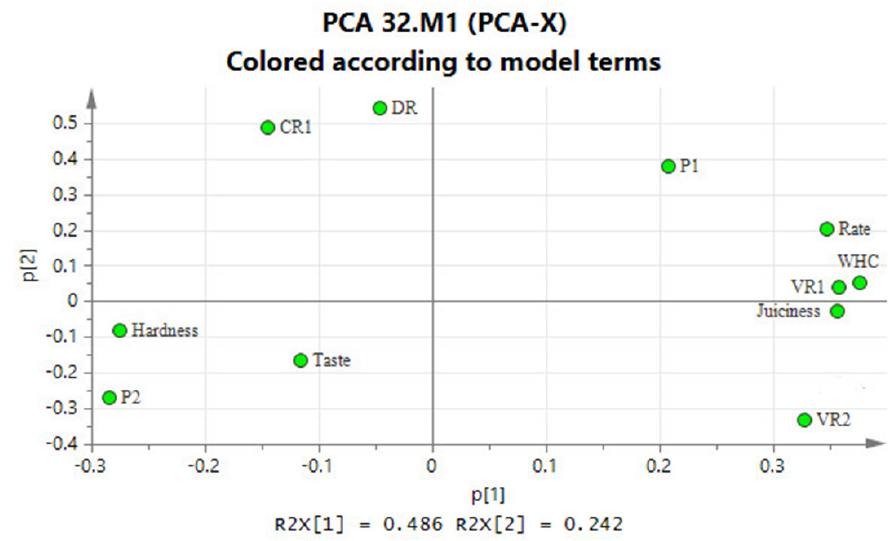
Figure 10. Correlation loadings plot from PCA on mean-centered data. VR1: volume ratio of dried samples, VR2: volume ratio of rehydrated samples, P1: porosity of dried samples, P2: porosity of rehydrated samples, Rate: rehydrate rate; CR1: relative conductivity ratio DR: dry matter loss ratio.